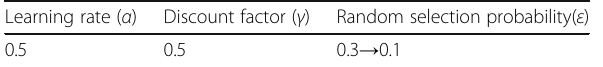
Table 4 Parameters for